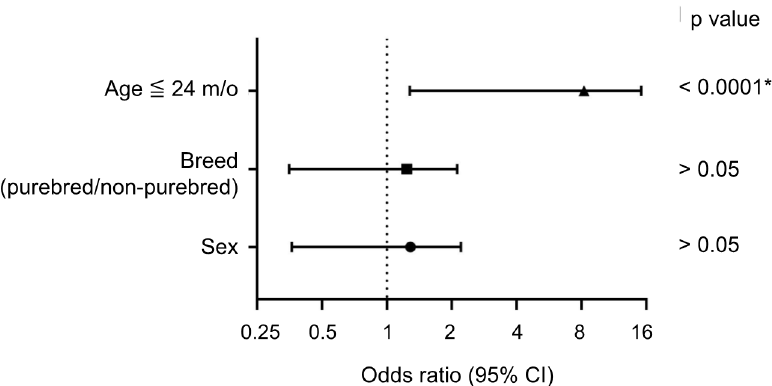
Figure 2. Odds ratio analysis for an included cat being diagnosed as FCoV positive based on age ( ≤ 24 m/o), breed, and sex. Odds ratios and 95% CIs were calculated using Fisher’s exact test. * p value < 0.05.